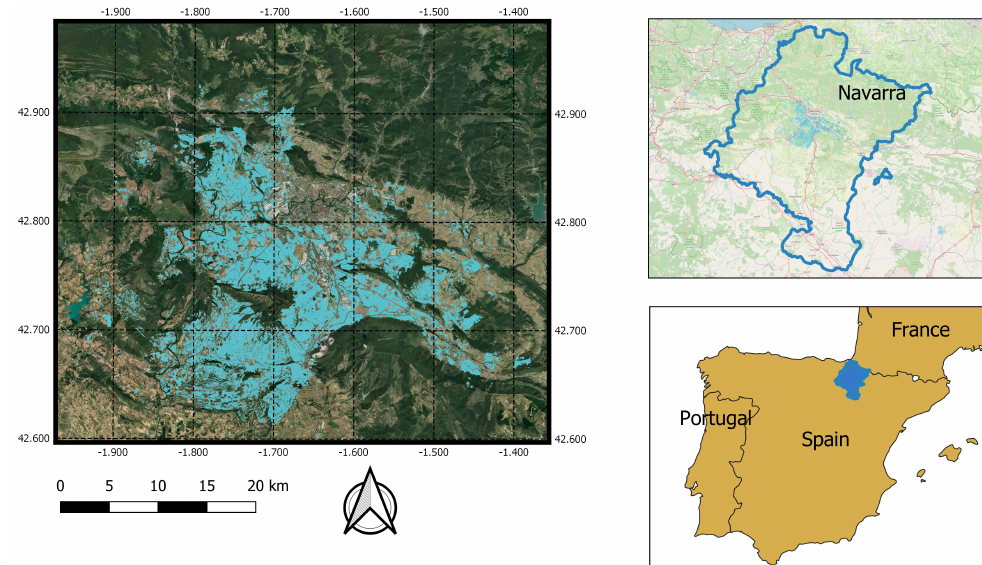
Figure 1. Study area located in Navarre, Spain. The scale is referred to the map on the left where the fields of interest are illustrated in light blue color. On the upper right map, the dark blue line indicates the borders of the entire province of Navarra. In the lower right map, we highlight the location of Navarra with respect to the entire country.